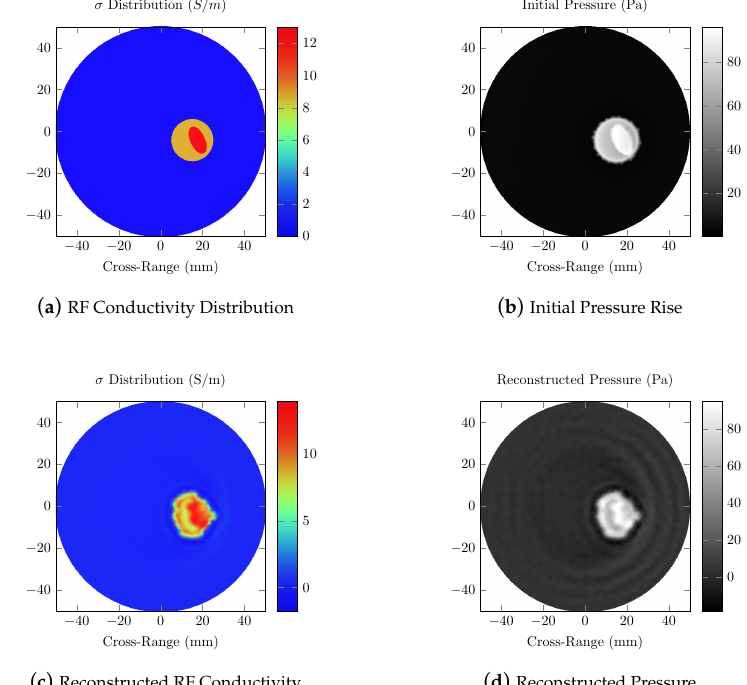
Figure 9. RF-induced acoustic computed tomography (RACT) simulations of the breast phantom using a 434 MHz RF source; ( a ) the true RF conductivity; ( b ) the initial pressure rise induced by the thermoacoustic effect; ( d ) the reconstructed pressure, calculated using the time-reversal algorithm; and ( c ) the reconstructed absorption, found by dividing the reconstructed pressure by the electric field intensity. The elliptical region with significantly larger conductivity is the tumor, surrounded by the glandular